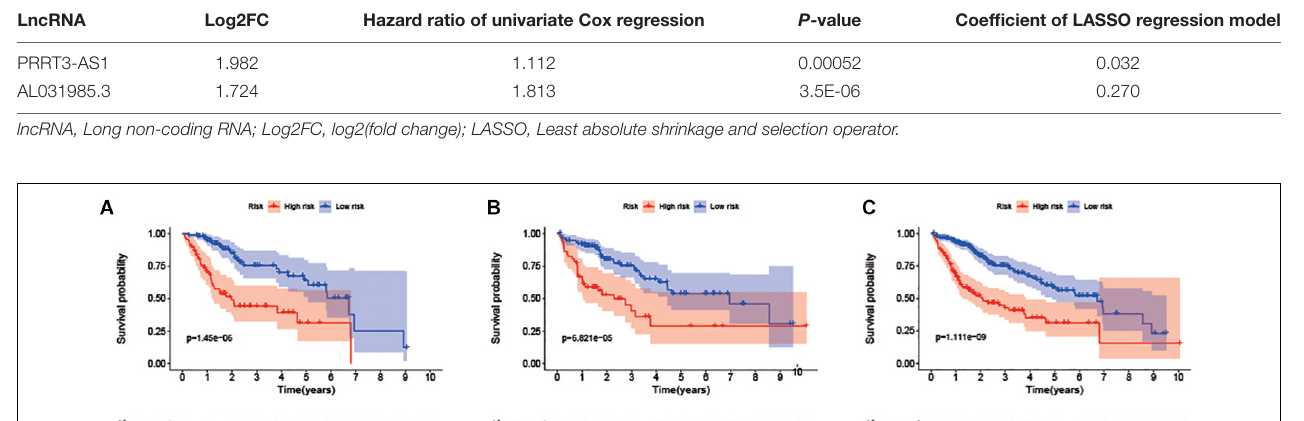
TABLE 2 | Two lncRNAs identified using the univariate Cox regression model and the LASSO regression model.